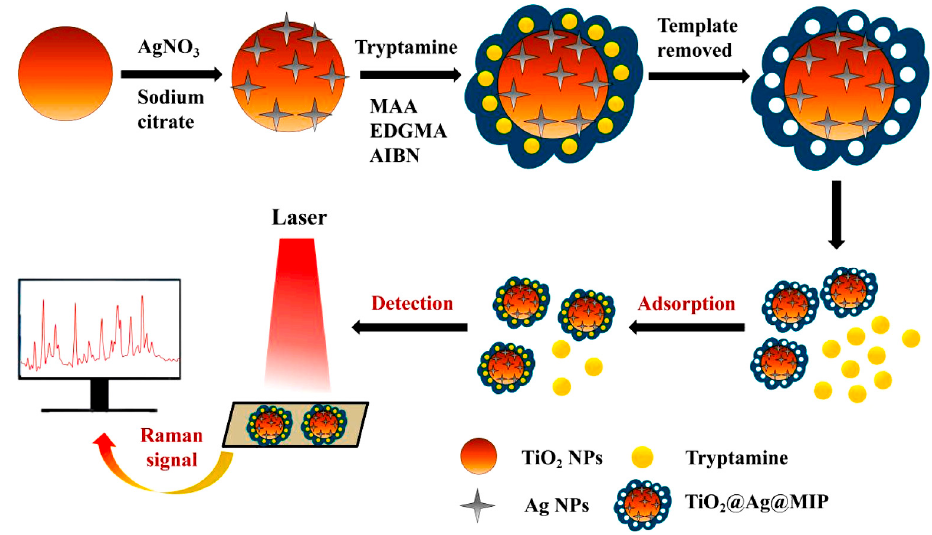
Figure 5. Fabrication of the TiO 2 @Ag@MIP SERS sensor and the detection of tryptamine [8]. Copy- right 2022 Elsevier (Amsterdam, The Netherlands).